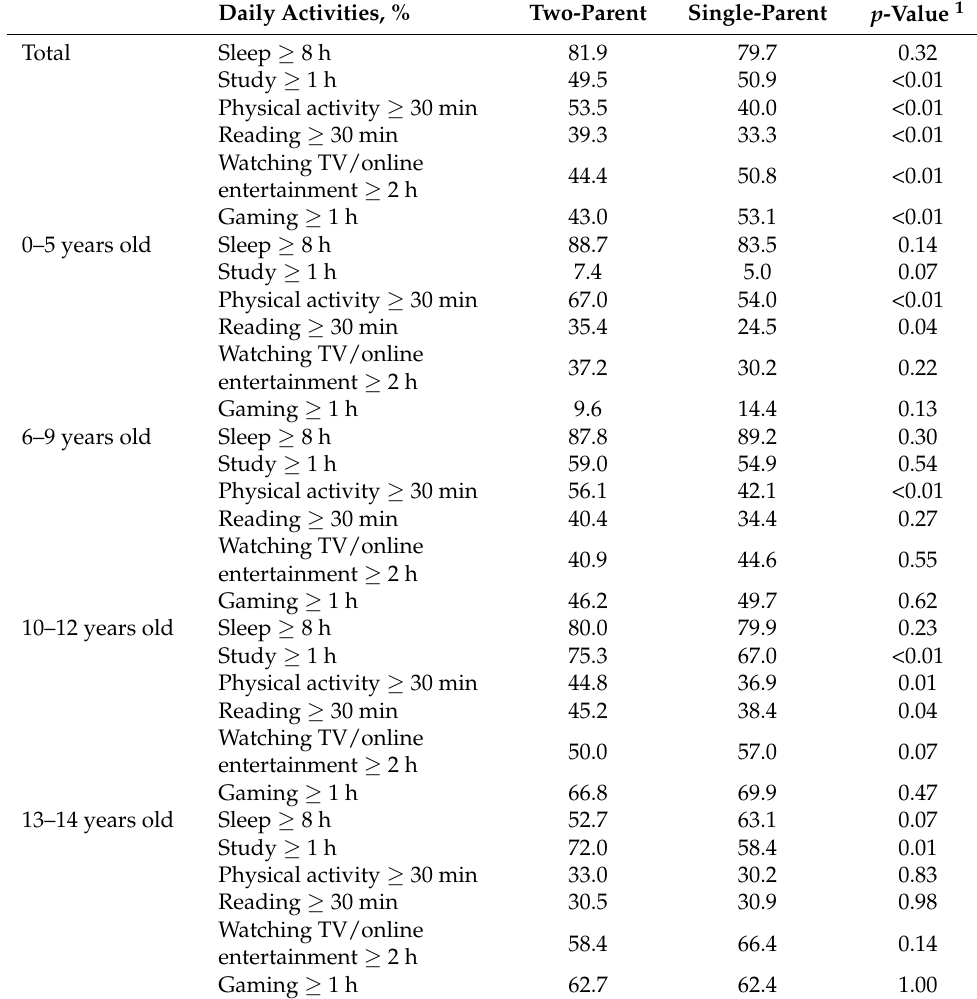
Table A1. Daily activity trends of the children stratified by age